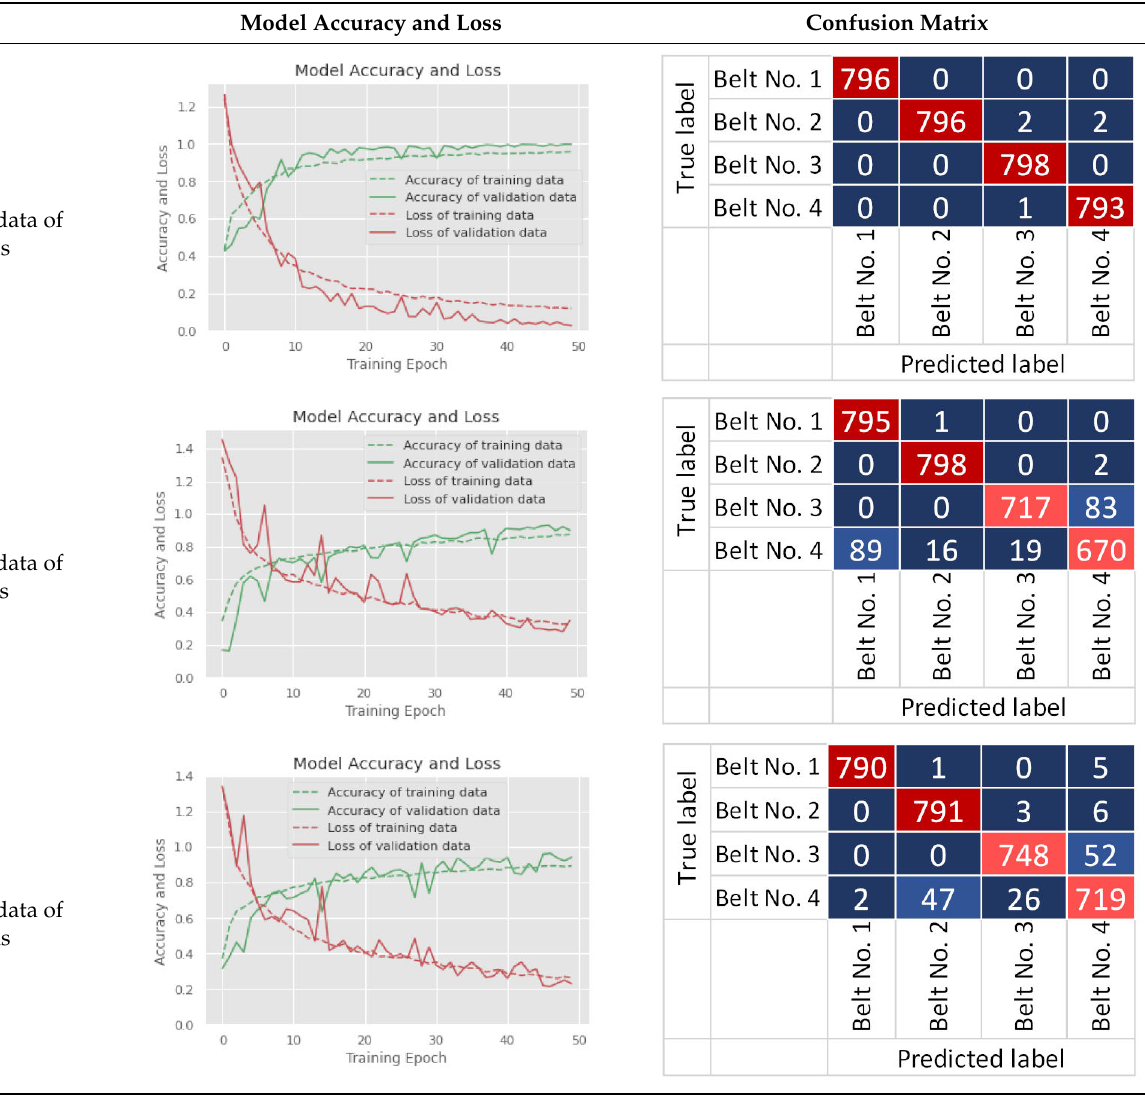
Table 3. Training curves and confusion matrix of single-axis vibration